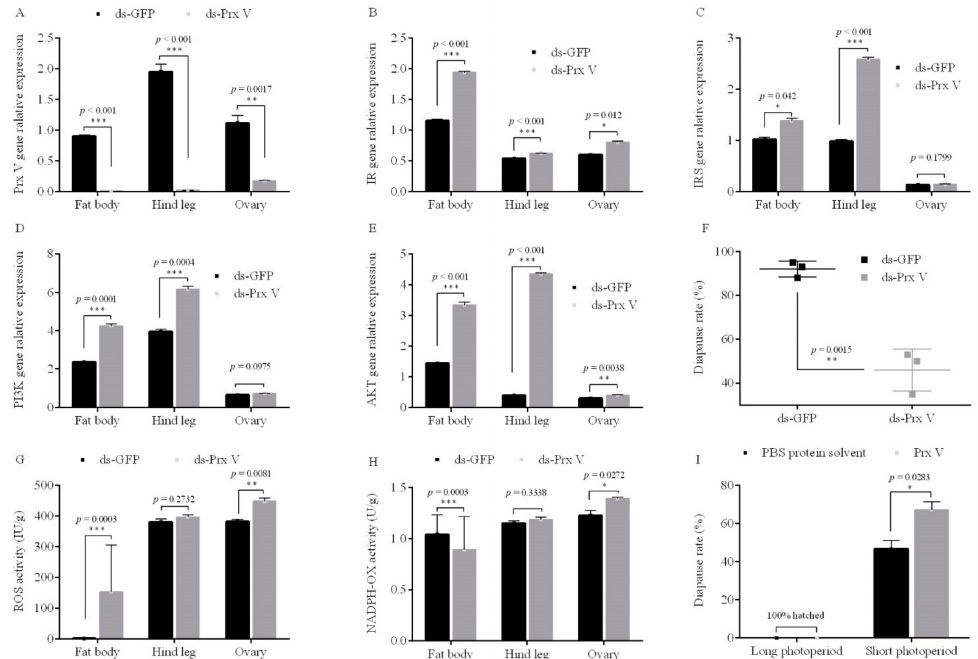
Figure 5. Gene relative expression, reactive oxygen species (ROS) and NADPH redox (NADPH-OX) changes in fat bodies, ovaries and hind legs, egg diapause incidence after injection of adults with the RNAi Prx V gene compared to GFP under short photoperiod conditions (L10:D14) (control), and egg diapause incidence after injection of adults with the Prx V protein compared to PBS protein solvent (control) under both long photoperiod (L16: D8) and short photoperiod conditions. ( A ) Prx V gene ( B ) IR gene, ( C ) IRS gene, ( D ) PI3K gene, ( E ) AKT gene relative expression, ( F ) egg diapause incidence, ( G ) ROS activity, ( H ) NADPH-OX activity after injection of adults with the RNAi Prx V gene compared to GFP (control). Data are the mean ± SEM from three independent replicates, the gray bar indicates RNAi treatments, while the black bar indicates GFP controls (* p < 0.05, ** p < 0.01, and *** p < 0.001 vs. GFP controls, Student’s t -test). ( I ) Egg diapause incidence after injection of adults with the Prx V protein compared to PBS protein solvent (control) under both long photoperiod and short photoperiod conditions. Data are the mean ± SEM from three independent replicates, the gray bar indicates Prx V protein treatment, while the black bar indicates PBS controls (* p < 0.05 vs. PBS protein solvent controls as assessed, Student’s t